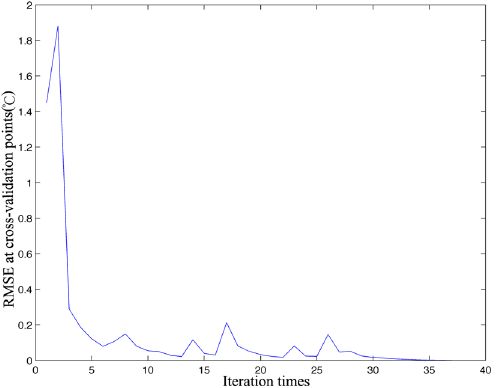
Fig 10. RMSEs at cross-validation points in the intermediate steps.